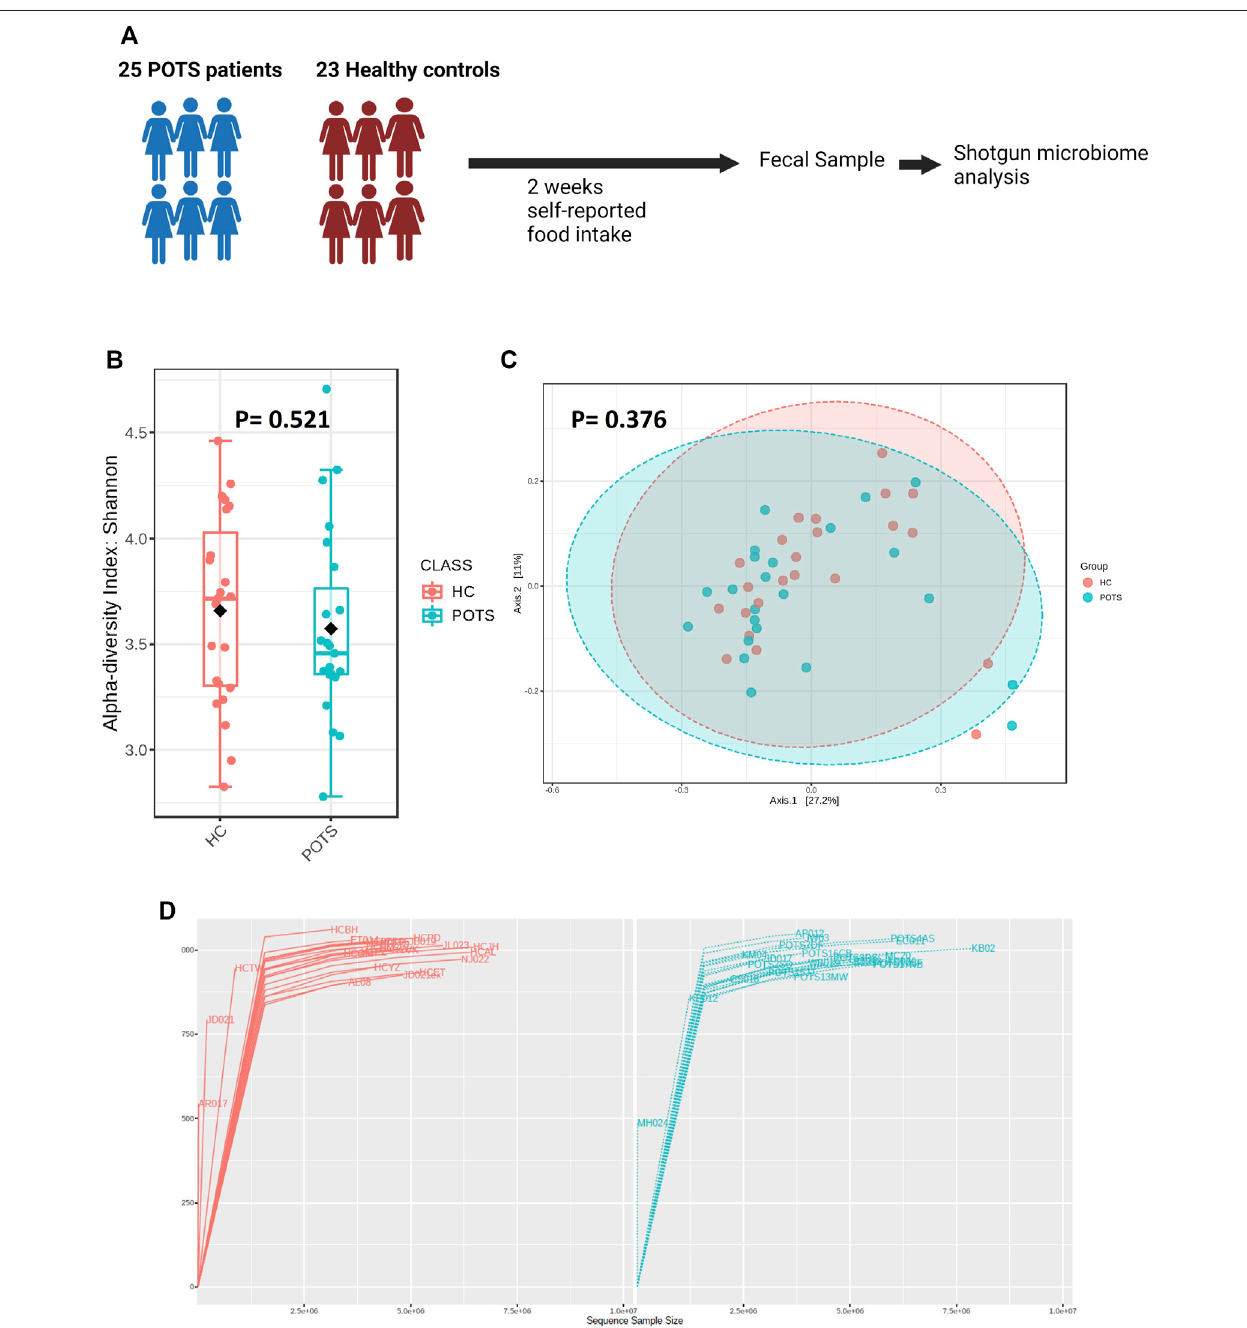
FIGURE4| RelationshipbetweenPOTSandthegutmicrobiome. (A) Studydesign,theself-reporteddietarycompositionwasestimatedfromdatarecordedinthe MyFitnessPal application for 2 weeks (B) Alpha diversity is presented as the Shannon index. (C) Principal coordinate axis representing beta diversity measure in POTS patients versus healthy controls (D) Rarefaction curve of OTUs in fecal samples. Shotgun sequencing data analyses were performed using MicrobiomeAnalyst and p < 0.05wassetforstatistical signi fi cance.Dataarepresented asmean±SEM.Statisticalanalyses wereperformedusing Student ’ s t -test. N =8forPOTSand N =13 for healthy control participants and p < 0.05 was set for statistical signi fi cance.